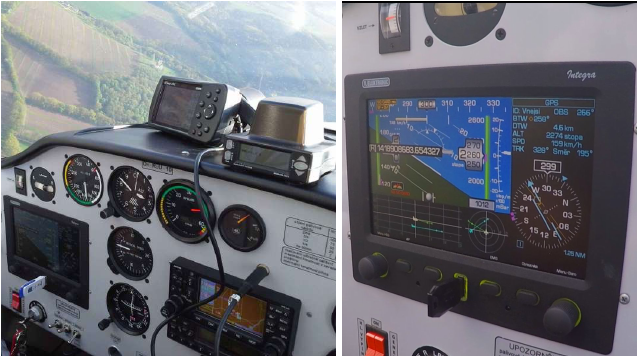
Figure 15. Aircraft pilot panel with the integrated advisory system—built-in EFIS Integra, Zaon PCAS with GPS on the flight panel and the rest of the system integrated under the